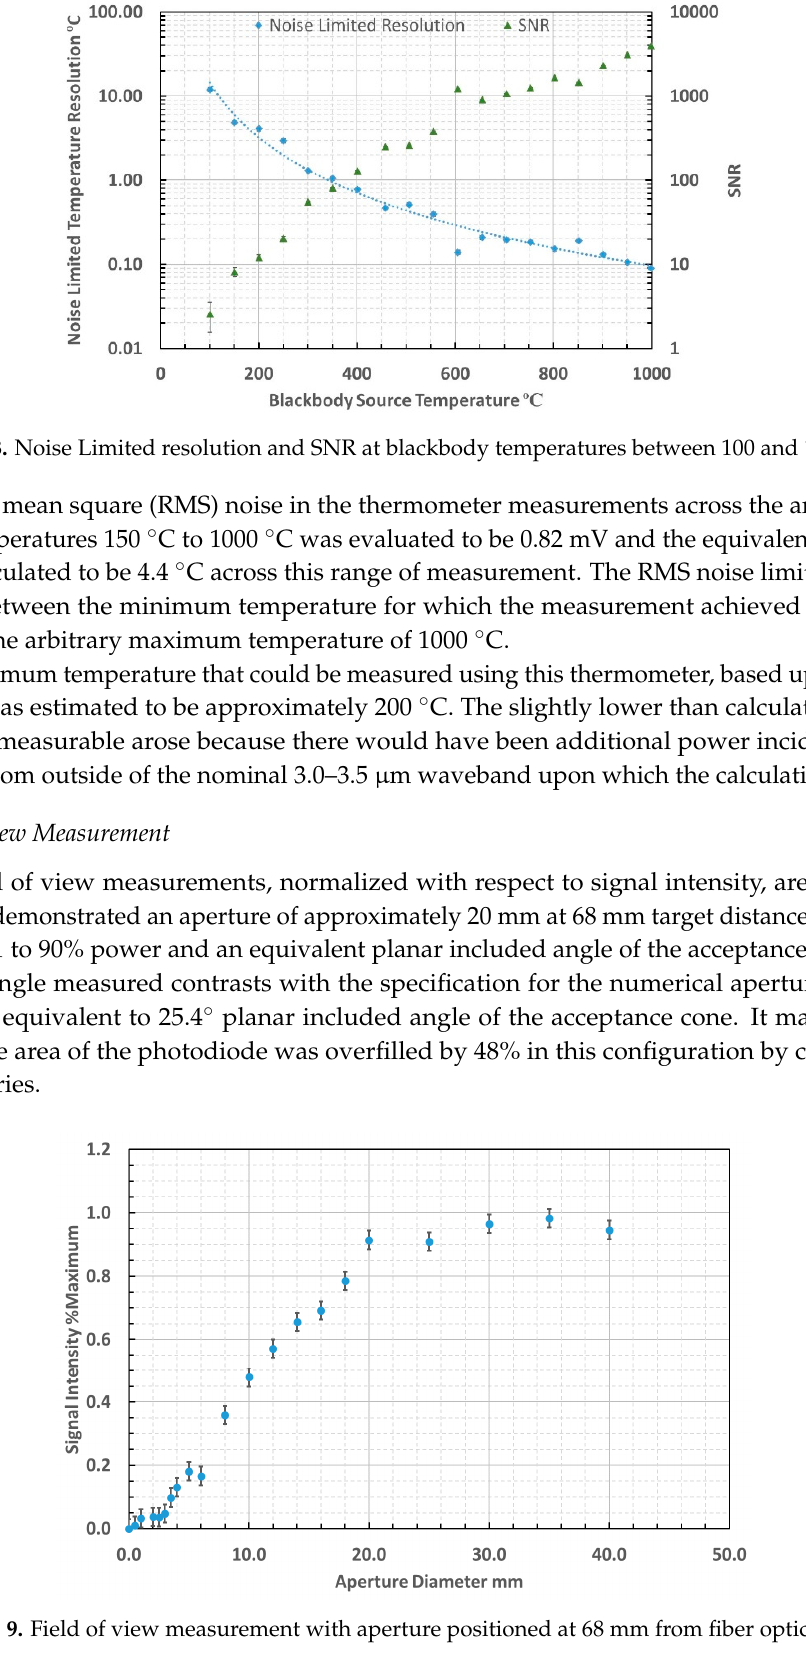
Figure 8. Noise Limited resolution and SNR at blackbody temperatures between 100 and 1000 °C.